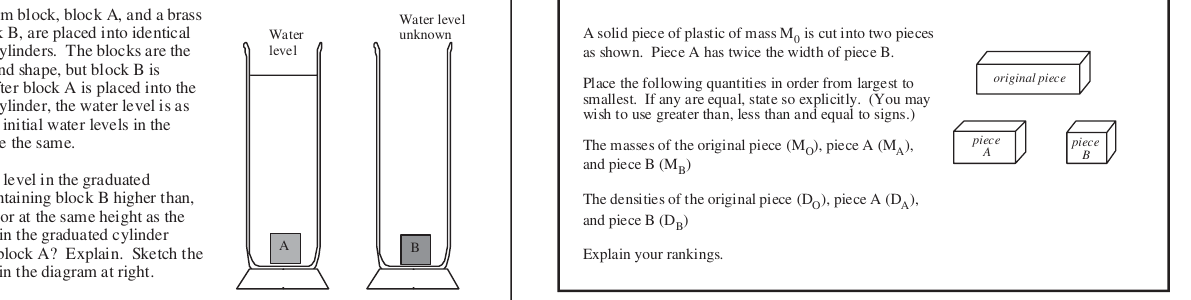
FIG. 1. Water displacement problem posed before instruction on an ungraded quiz in Phys/Chem 102 as well as a comparison course.